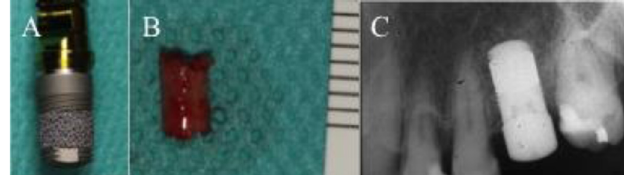
Fig. 7. Trabecular Metal Implant placement (Zimmer Dental®). A poor-bone quality implant, with large diameter was chosen to replace the upper left fi rst molar. (A) The implant presents a structure with interconnected-porosity made of tantalum. (B) The drilling bone was harvested to be analyzed. (C) The 3 months postoperative radiograph shows a good